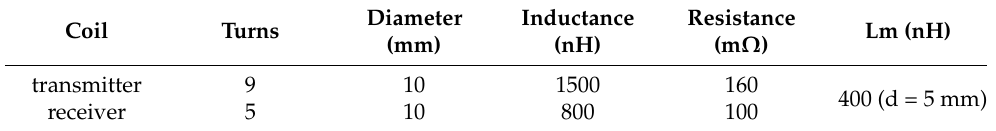
Table 1. Coils specific parameters. Lm represents the mutual inductance of the two coils. Coil Turns